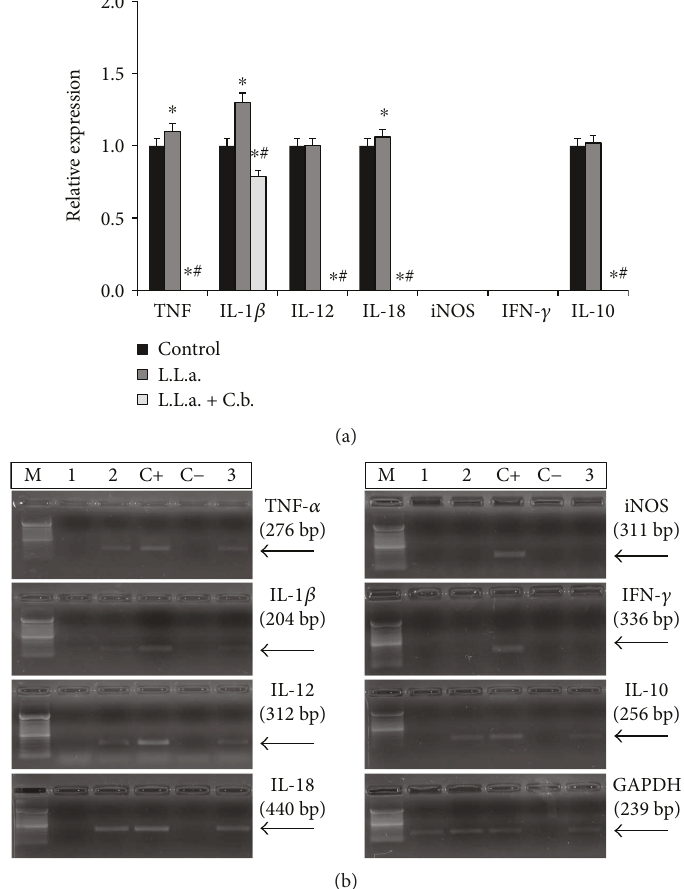
Figure 3: Expression levels of cytokine and iNOS mRNA by macrophages infected with L. ( L. ) amazonensis and treated with hydroalcoholic extract of C. brasiliense . (a) L.L.a: L. ( L. ) amazonensis ; C.b.: C. brasiliense . L.L.a+ C.b.: peritoneal macrophages from BALB/c mice were infected with promastigotes of L. ( L. ) amazonensis (10 parasites: 1 macrophage) for 3h and then treated with hydroalcoholic extract of C. brasiliense (30 μ g/ml) for 3h; L.L.a.: macrophages infected and untreated; control: macrophages uninfected and untreated were incubated only with RPMI during 6h (negative control). ∗ p < 0 05 signi fi cantly compared to negative control; # p < 0 05 compared to infected and untreated macrophages. (b) Cytokine mRNA expression by semiquantitative reverse transcriptase-polymerase chain reaction (RT-PCR) DNA fragments was separated in 1.5% agarose gel electrophoresis and revealed with ethidium bromide in a transilluminator. M: molecular marker; C − : ampli fi cation negative control (H O); C+: DNA obtained from macrophages stimulated with 5 μ g/mL of LPS 2 (positive control); 1 and MO: macrophages (negative control, uninfected and untreated); 2 and L.L.a. +C.b.: macrophages infected with L. ( L. ) amazonensis and treated with C. brasiliense ; 3 and L.L.a.: macrophages infected with L. ( L. ) amazonensis